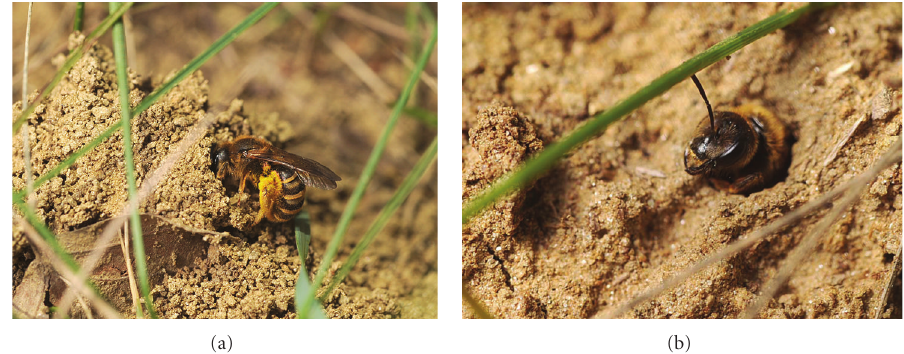
Figure 1: Halictus scabiosae . (a) Homing forager bee with pollen on its coxae and femurs reopening the nest entrance hole that had been previously closed by the queen. (b) Guard bee at the nest